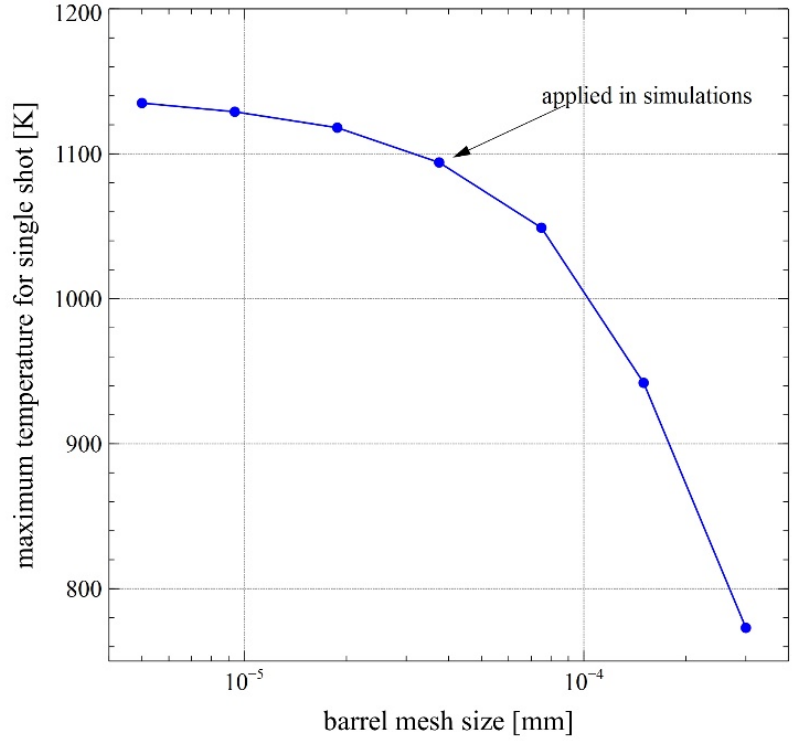
Figure 12. Influence of barrel mesh size on the maximum temperature of the barrel interior surface for single shot.